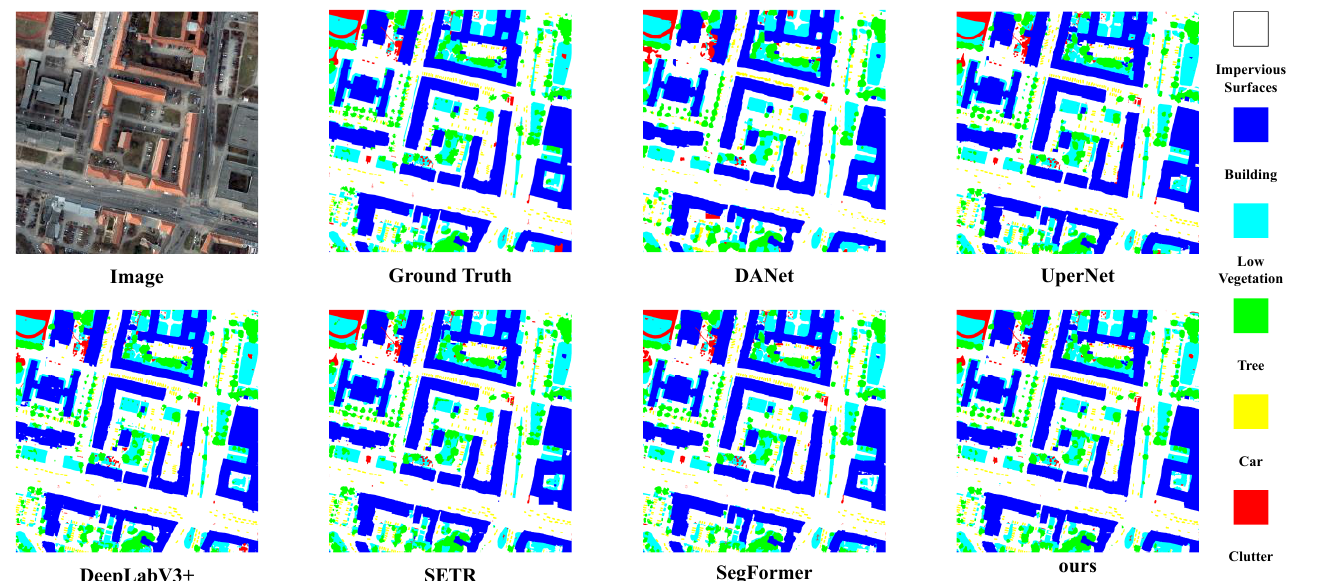
Remote Sens. 2022 , 14 , x FOR PEER REVIEW 16 of 20 Figure 9. Visualization of results from the Potsdam test set. Figure 9. Visualization of results from the Potsdam test set.